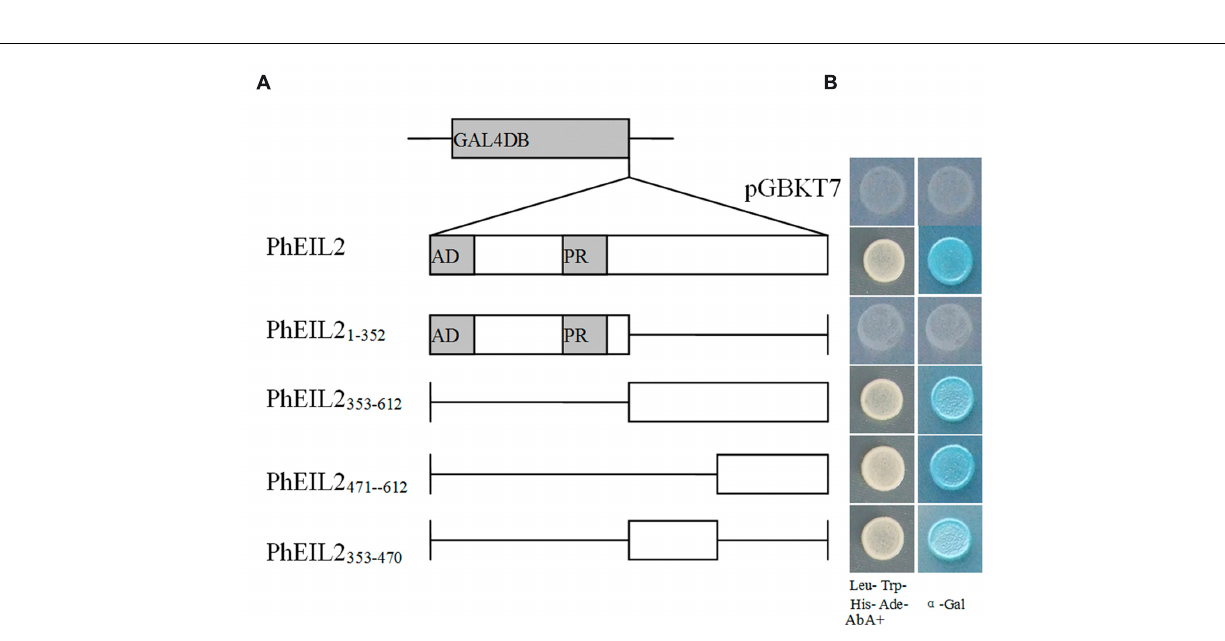
Frontiers in Plant Science |